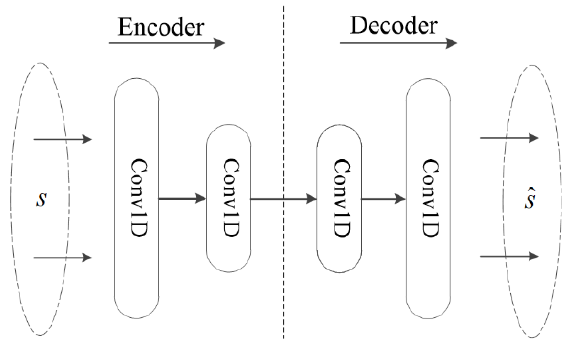
Figure 2. Convolutional autoencoder network structure.